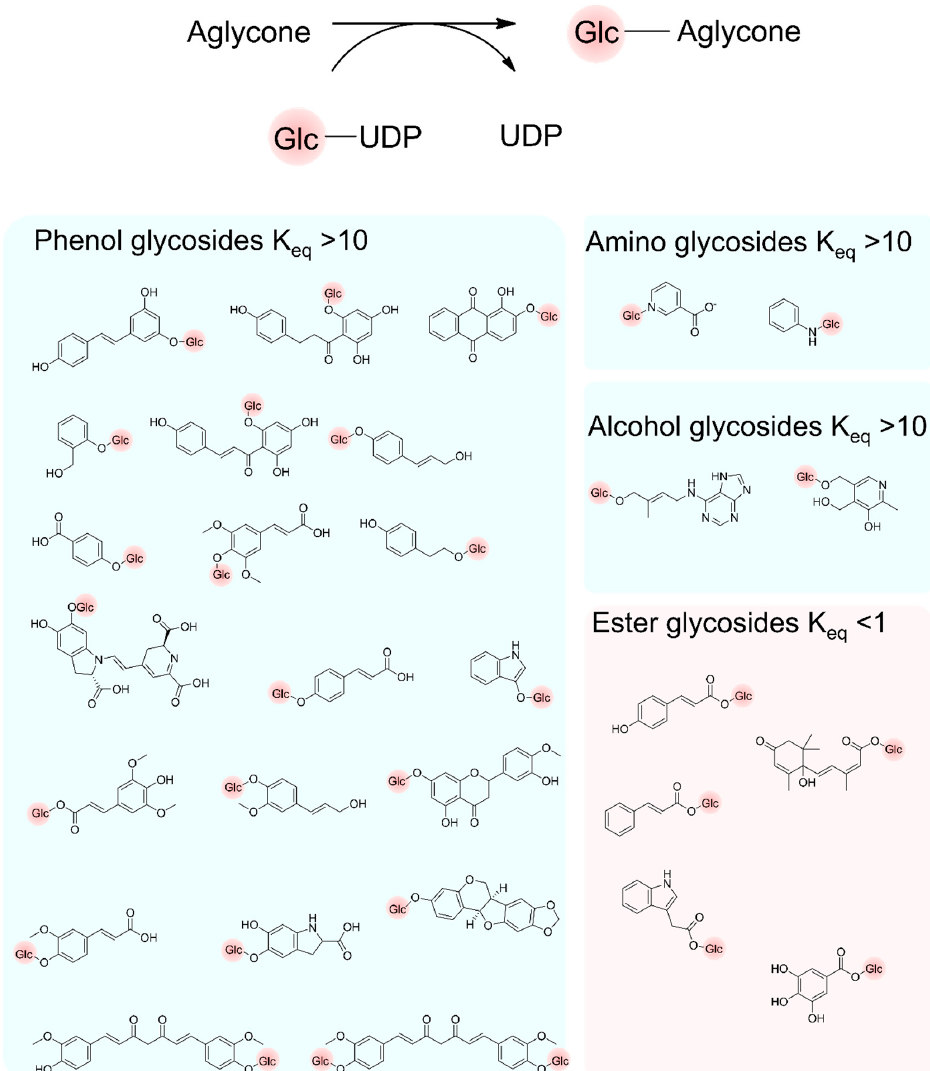
Figure 6. Glycosylation of aglycones producing phenolic glycosides, amino glycosides, alcohol glycosides, ester glycosides, and disaccharides with their estimated K eq . The K eq was calculated from the Gibbs free energy Δ G r ’ 0 using the eQuilibrator web interface (http://equilibrator.weizmann.ac.il) [155] assuming the following conditions: ionic strength 0.1 M, pH 7.0, aglycon (1 mM), UDP (1 mM), UDP- D -glucose (1 mM), glycosylated product (1 mM), and 298 K.